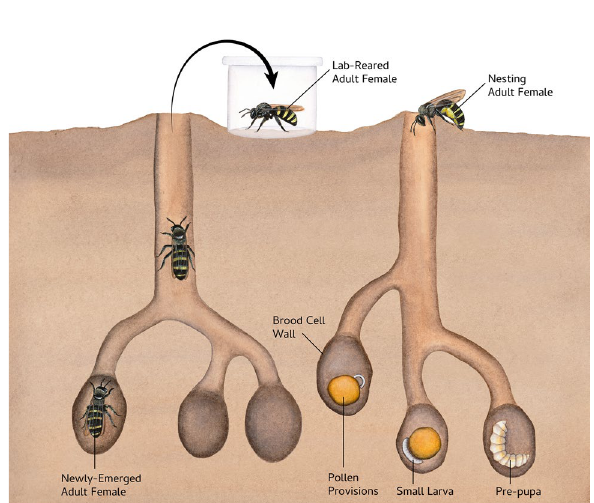
Figure 1. Experimental overview. We sampled adult females as they emerged from their nests after completing development in early summer. Some of these adult females were frozen immediately (newly-emerged) and others were reared in the lab for 10 days (lab-reared). We also sampled adult females that were free-flying and actively nesting (nesting females). We excavated nests to collect brood cell walls, pollen provisions, small larvae, and pre-pupae. Illustration by Julie Johnson (Life Science